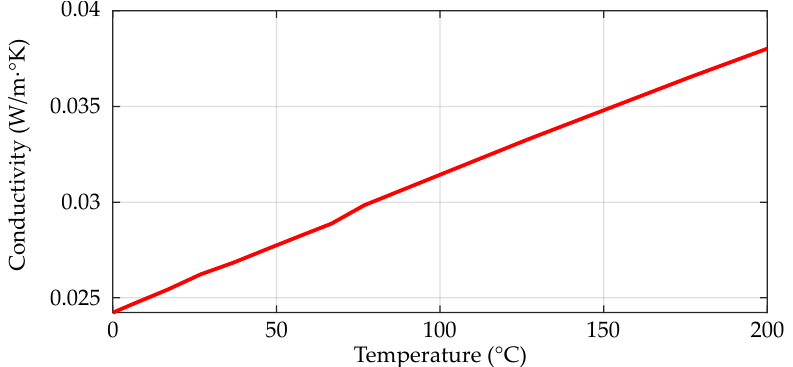
Figure 2. Thermal conductivity of air at 1 atm in function of the temperature, adapted from Refer- ence